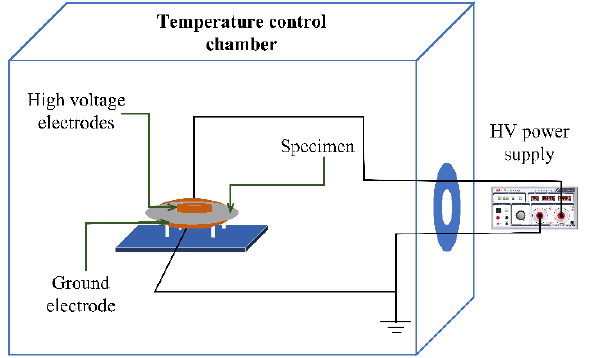
Figure 1. Schematic diagram of the pre-injected space charge in PP.